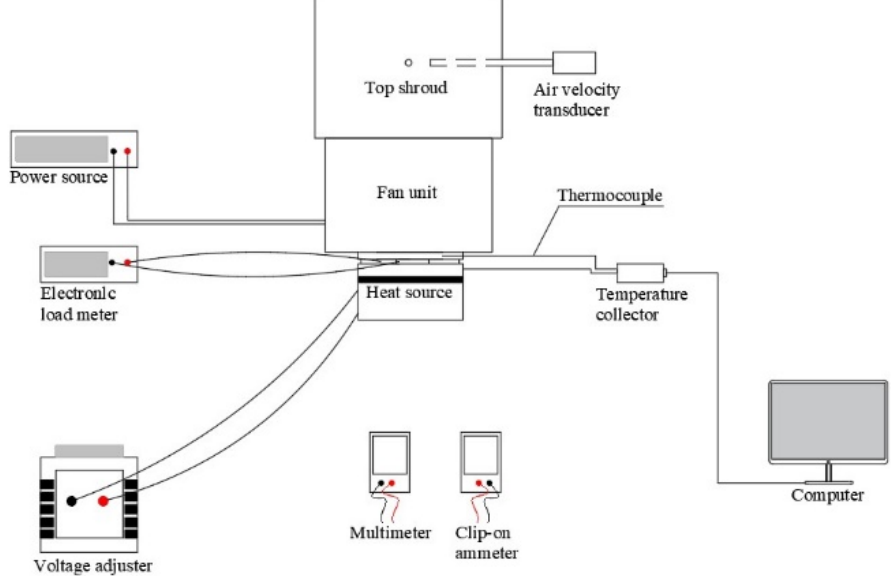
Figure 1. Schematic of the experimental setup.